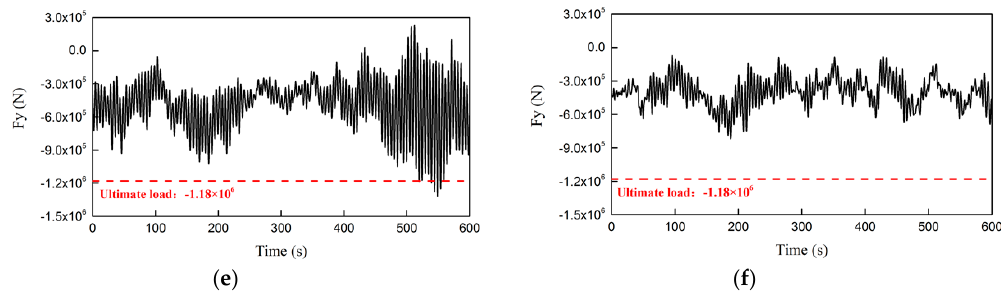
Figure 10. Variation of Fy in ten minutes. ( a ) Inflow of 0°; ( b ) Inflow of 30°; ( c ) Inflow of 60°; ( d ) Inflow of 90°; ( e ) Inflow of 120°; ( f ) Inflow of 150°.